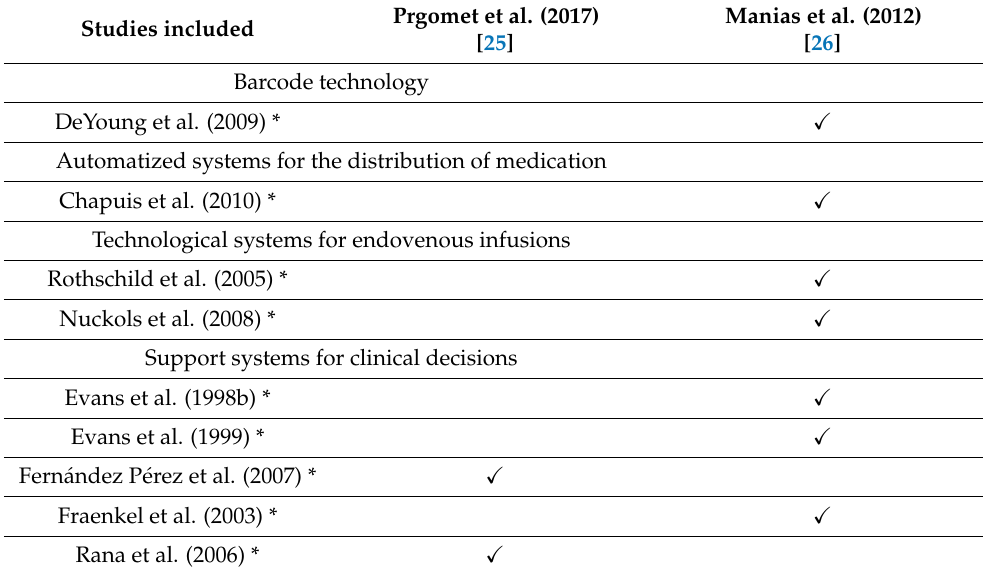
Table 3. Studies on interventions to prevent medication administration errors included in the systematic reviews included in this umbrella